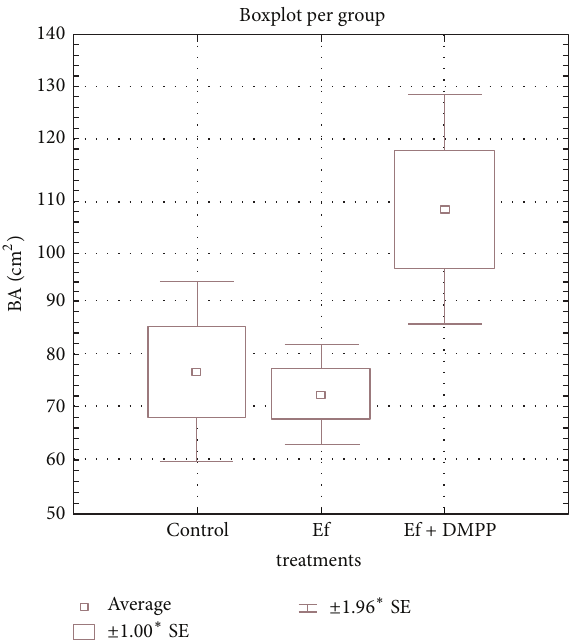
Figure 3: Viglio clone growths measured by Basal Area BA = 𝜋( DBH /2) 2 by groups. Control is Viglio without treatment, Ef is Viglio treated with bovine manure effluent, and Ef + DMPP is Viglio grown with effluent combined with 3,4